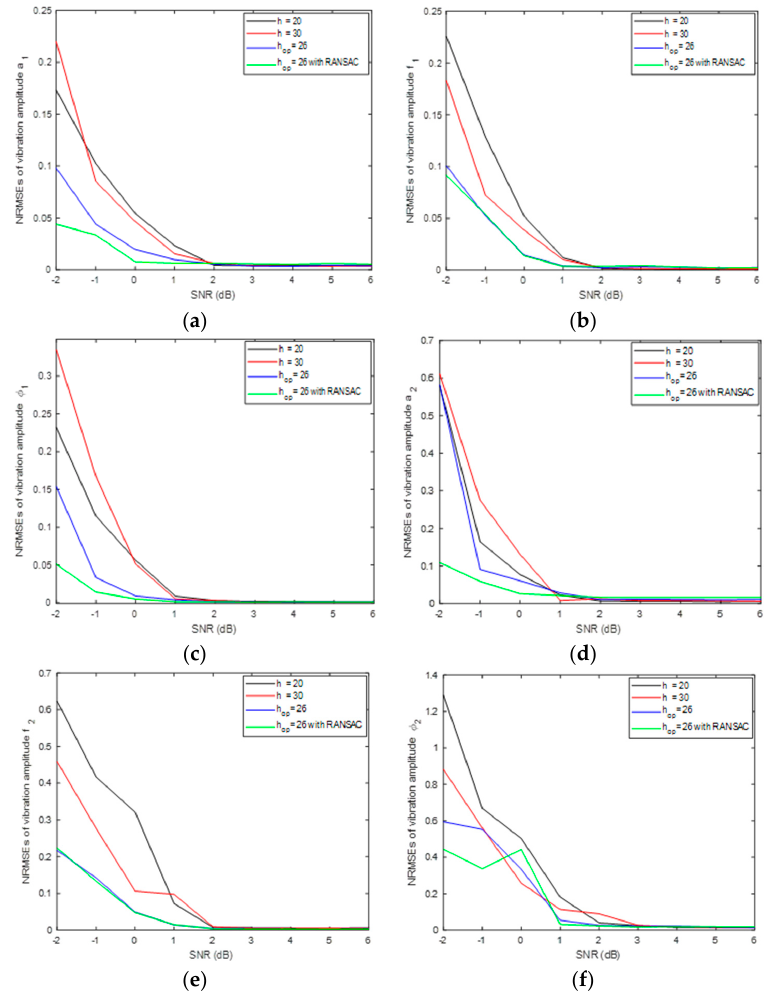
Figure 4. The estimation accuracy of signal parameters for different estimation methods. ( a ) vibration amplitude a 1 ; ( b ) vibration frequency f 1 ; ( c ) initial phase φ 1 ; ( d ) vibration amplitude a 2 ; ( e ) vibration frequency f 2 ; and ( f ) initial phase φ 2